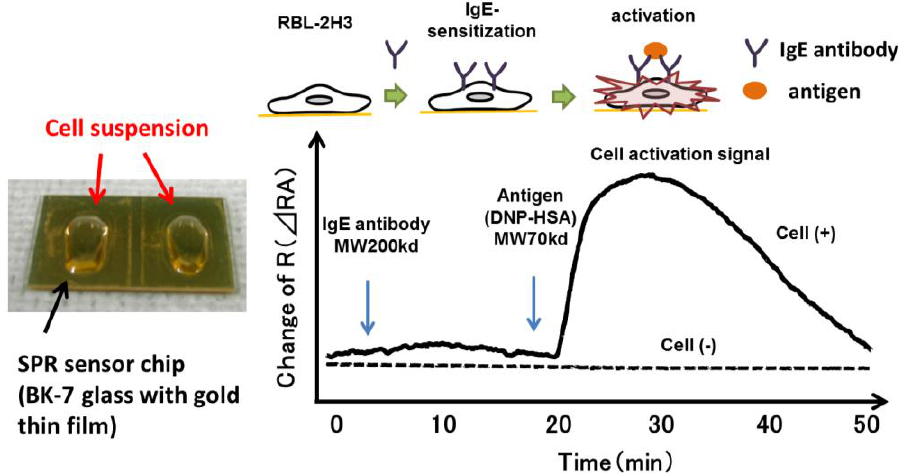
Figure 2. SPR signals (change of RA) obtained by binding of anti-DNP IgE and DNP-HSA to RBL-2H3 cells, which express the high affinity IgE receptor (FcεRI) on cell surface. Cells were cultured on the surface of the SPR sensor and incubated first with anti-DNP IgE and then with